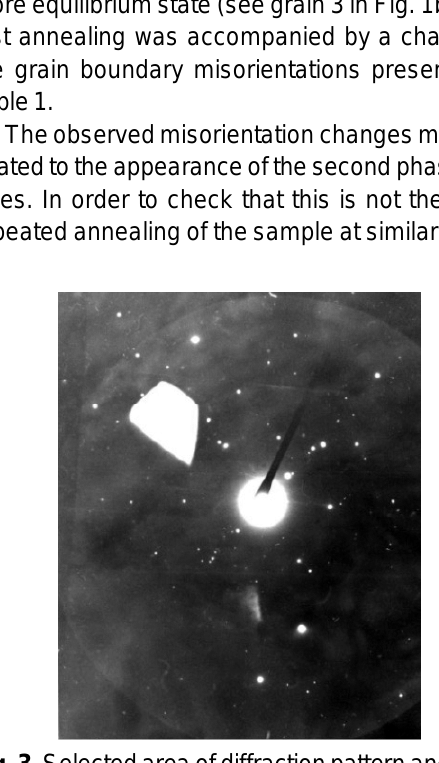
Fig. 3. Selected area of diffraction pattern and dark- field image of the reflex (110) of the second phase particle in grain 4.